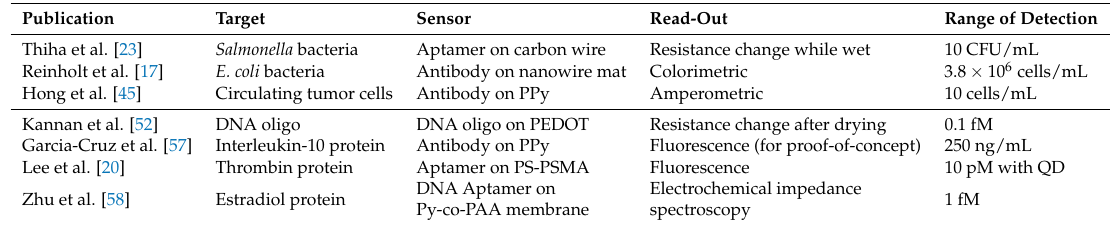
Table 1. Overview of relevant diagnostic setups and their range of